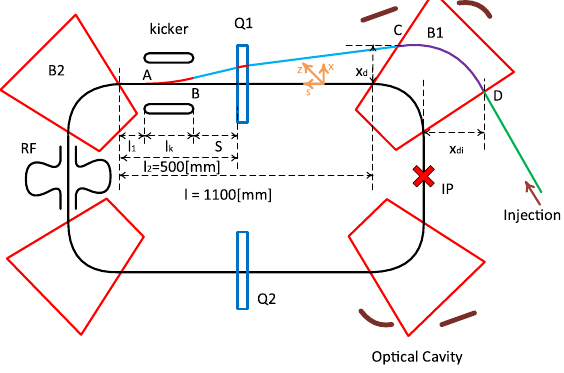
FIG. 9. Schematic top view of the injection system in the 4.8 m ring. The injected beams enter the fringe field region of the dipole magnet B1 at the point D, and then, leave B1 at point C. x and di x indicate the horizontal coordinates of point C and D in the d Frenet-Serret coordinate system, which is expressed as ð x; z; s Þ in this figure ( z axis is perpendicular to the paper), respectively. l 1 , S , and l 2 illustrate the location of the kicker. l is the length of the k kicker. The injected beams pass through the quadrupole magnet Q1 before entering into the kicker. The rf cavity and the interaction point (IP) are located at the center of the short straight sections. The injected particle moves from right to left, passing through the fringe field region of the dipole magnet and the quadrupole. The optimum distance and divergence between the central trajectory of the injected beam and the reference orbit in the ring are about 24.8 mm and 97.8 mrad at the ) before x